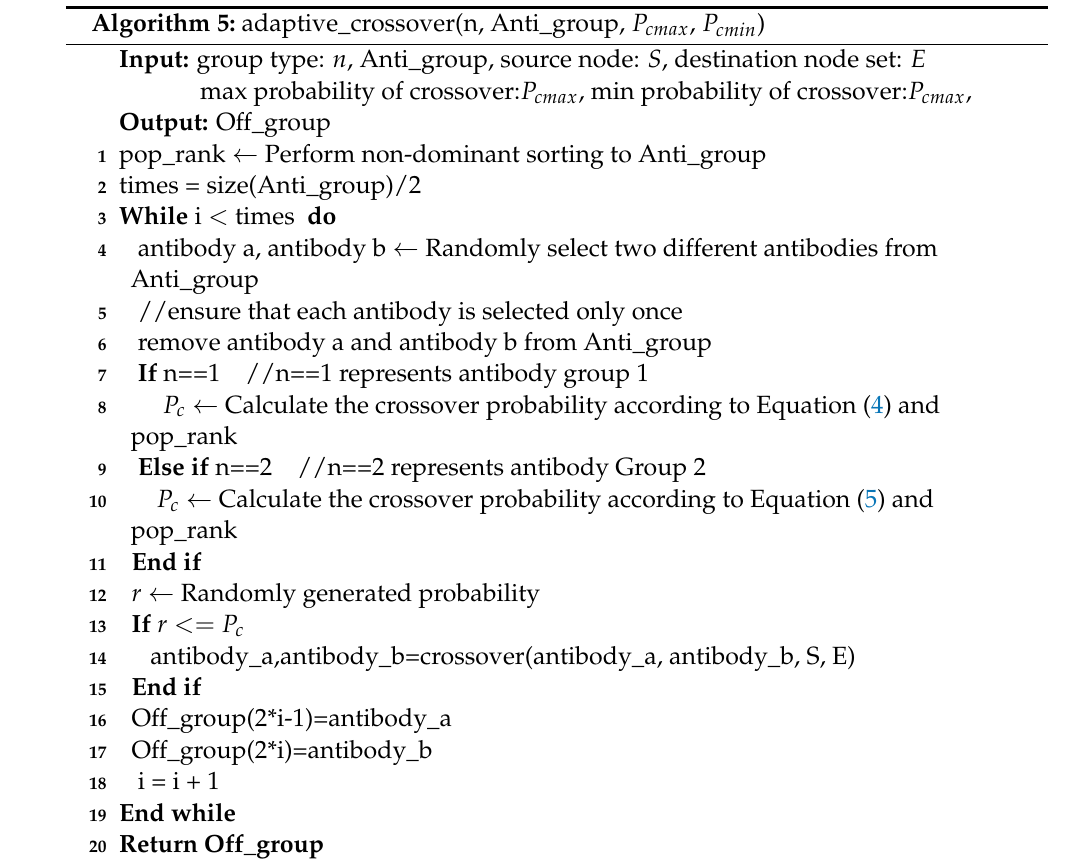
Algorithm 5: adaptive_crossover(n, Anti_group, P cmax , P cmin